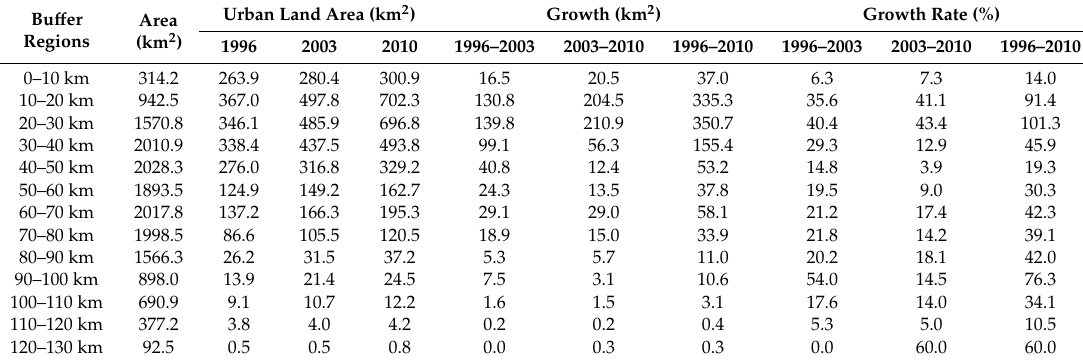
Table 2. Distribution of urban land area in multiple bu ff er rings circling the municipal government. Bu ff er Regions